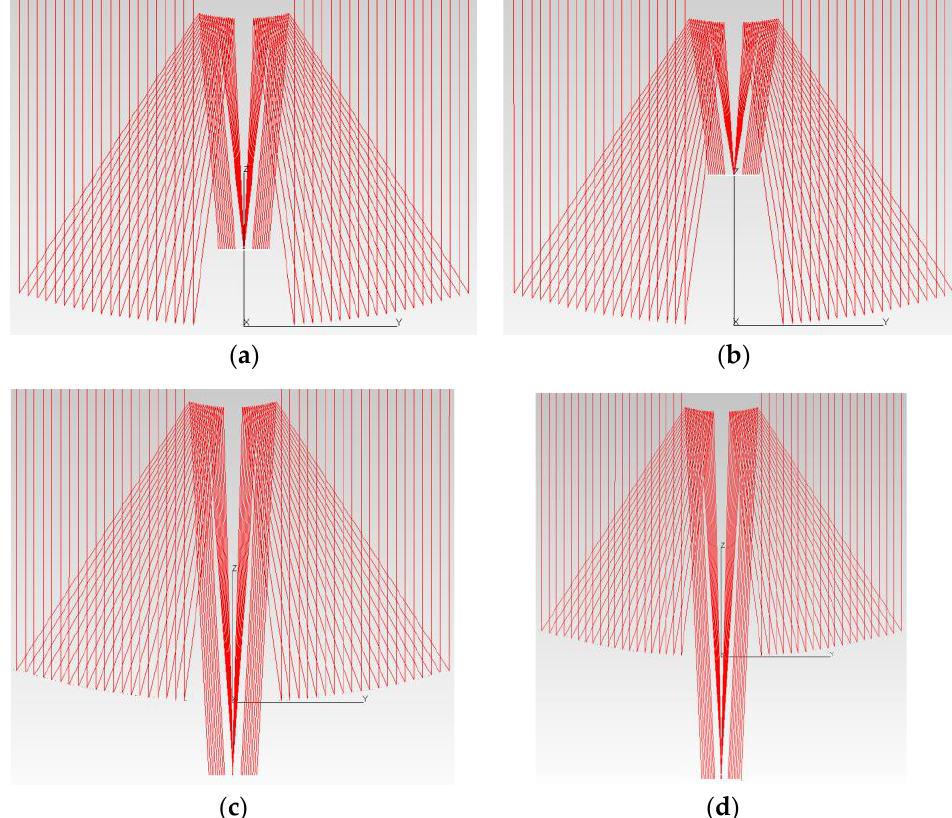
Figure 9. The sketches of ray-tracing paths at different receiving heights between −2 m and ~2 m. ( a ) Receiving height 1 m. ( b ) Receiving height 2 m. ( c ) Receiving height −1 m. ( d ) Receiving height − 2 m.